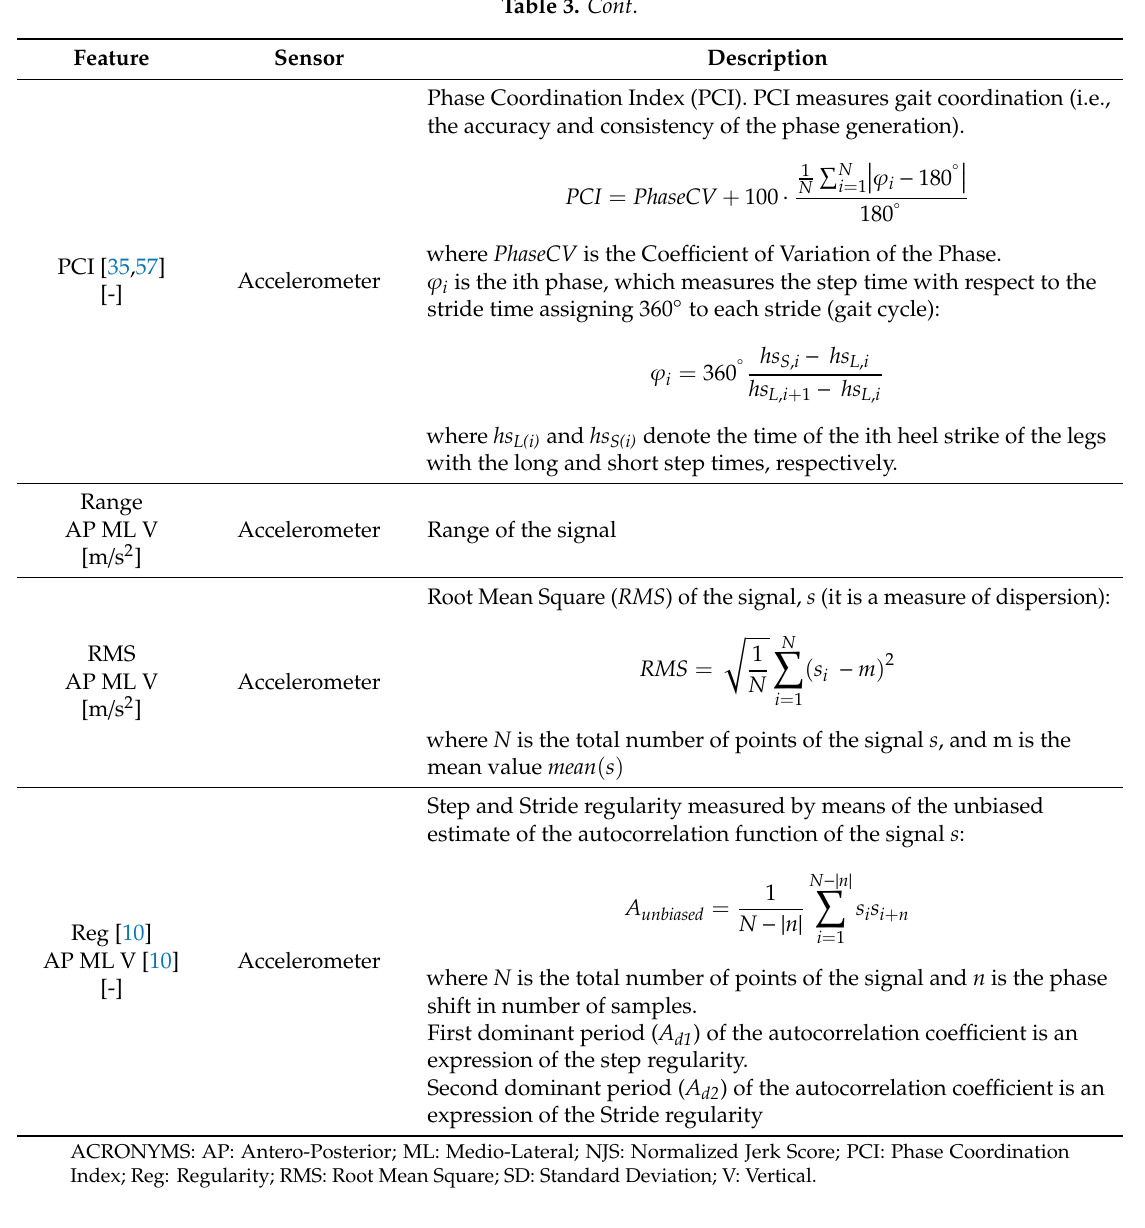
Table 4. Sensor-based features extracted from the CST